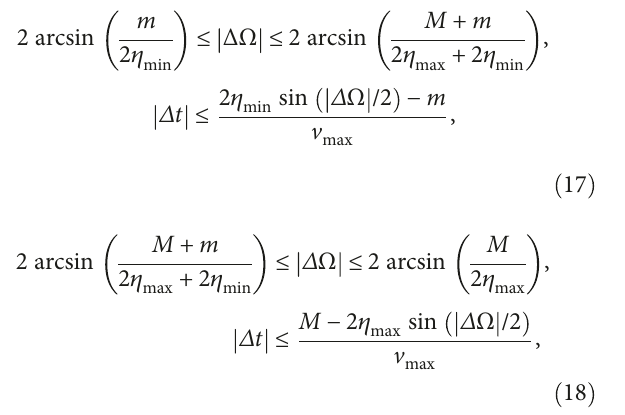
Figure 3: The feasible region in Case 1.